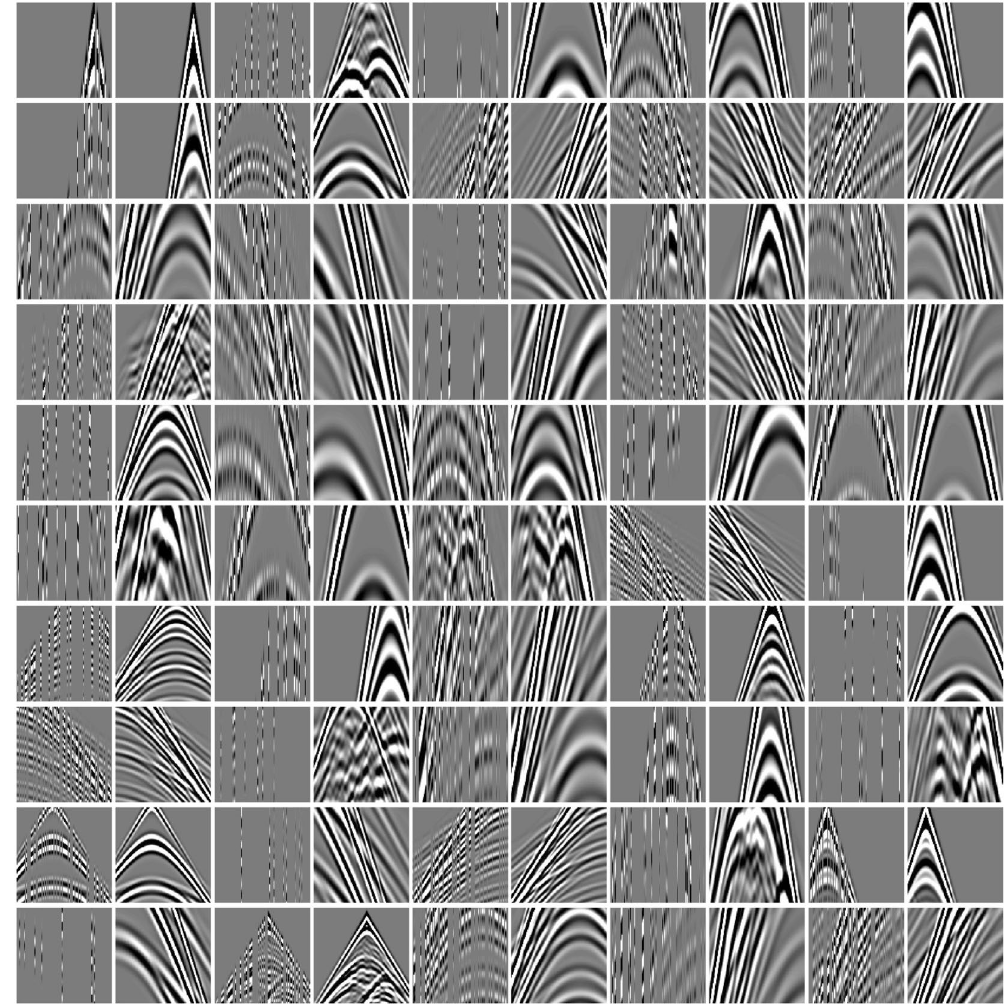
Figure 6. Model input-output pairs, which are randomly selected from the training data set. Each pair is composed of irregularly missing incomplete data (in the odd column, i.e., the model input X ) and the corresponding complete data (in the even column, i.e., the model output Y ref ). The size of each panel is 112 × 112.